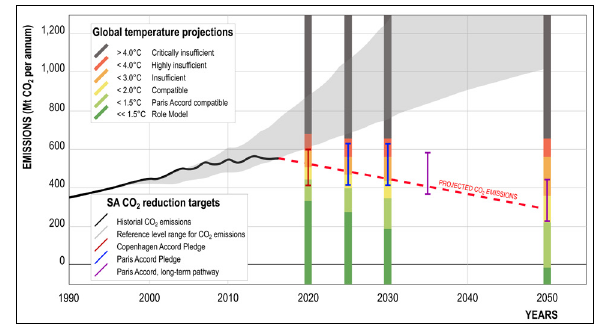
emissions for South Africa, as per climate change Figure 1: Projected CO 2 mitigation scenarios. Overall global temperature rise predictions are also presented. 18